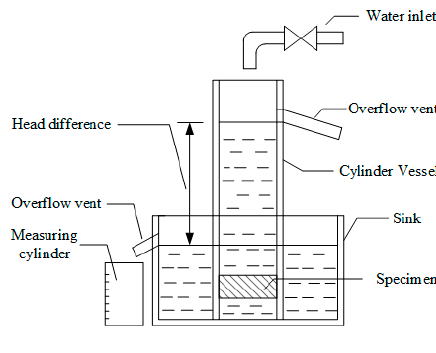
Figure 4. Permeability test: ( a ) test setup, ( b ) specimen.